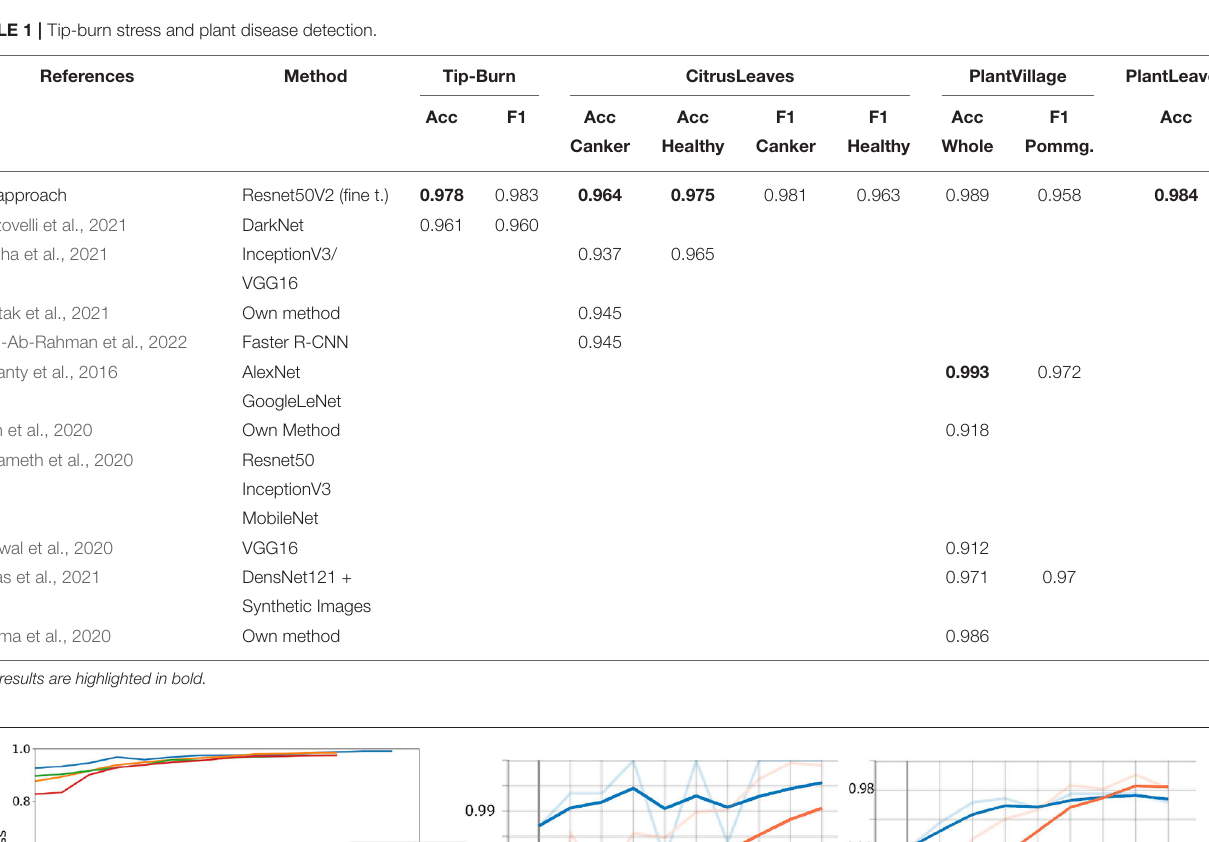
FIGURE 7 | Preliminary leaves segmentation for PlantLeaves, PlantVillage, and CitrusLeaves, from left to right in the order.